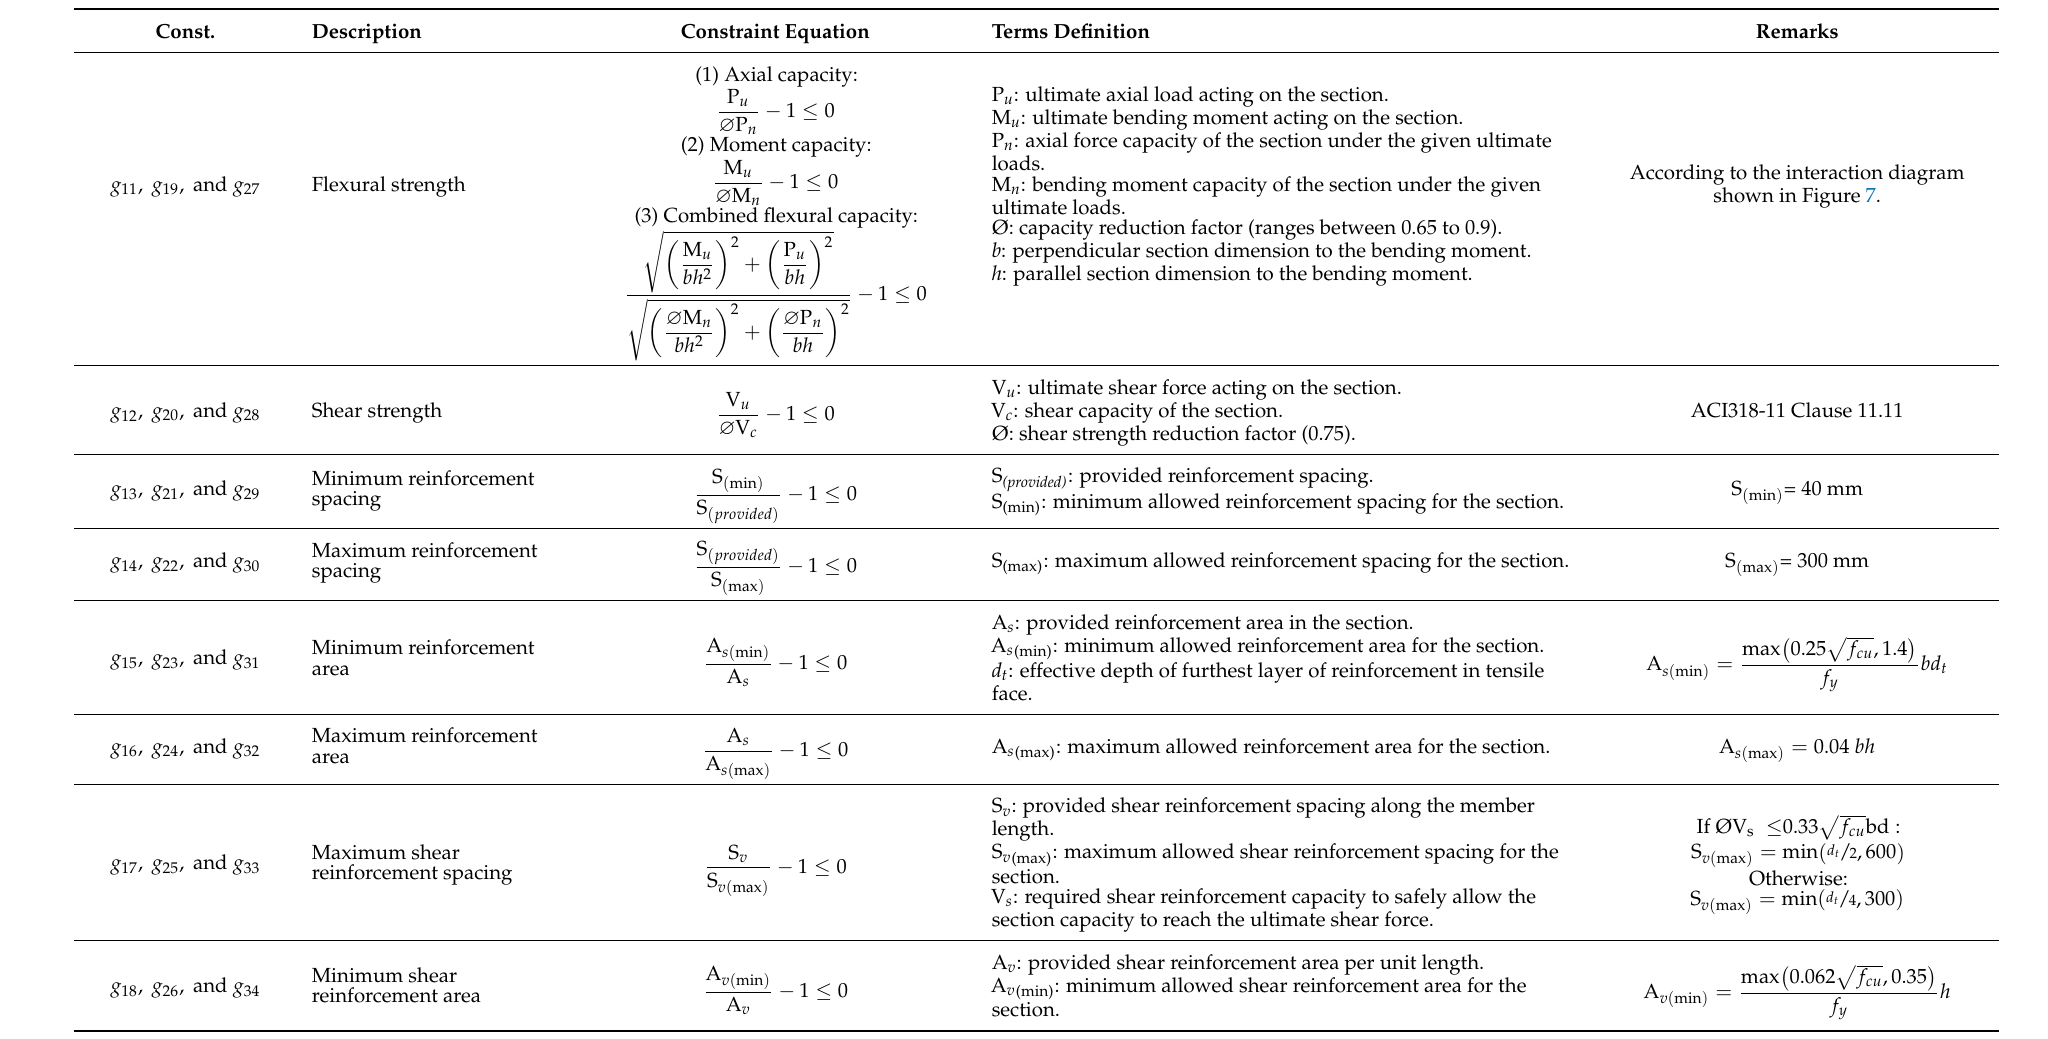
Table 8. Auxiliary members’ constraints